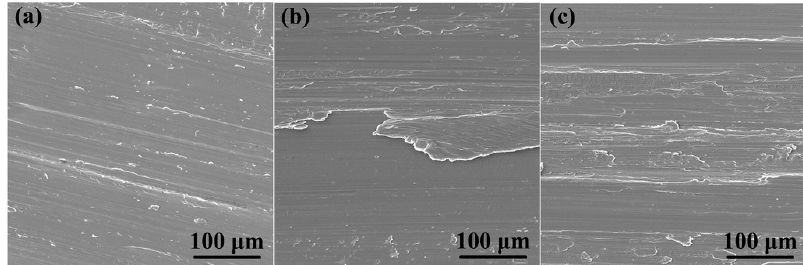
Figure 13. Worn surface morphologies of UIRP samples at 637 r/min after ( a ) 100 cycles, ( b ) 200 cycles and ( c ) 300 cycles. Profile morphologies of the untreated samples are shown in Figure 14. The untreated sample surface is even without distinct plastic flow at 250 r/min, as shown in Figure 14a. The tribo-layer is more obvious and continuous at 478 r/min in Figure 14b, and the tribo-layer is further compact and continuous with plastic flow in the subsurface at 637 r/min in Figure 14c.